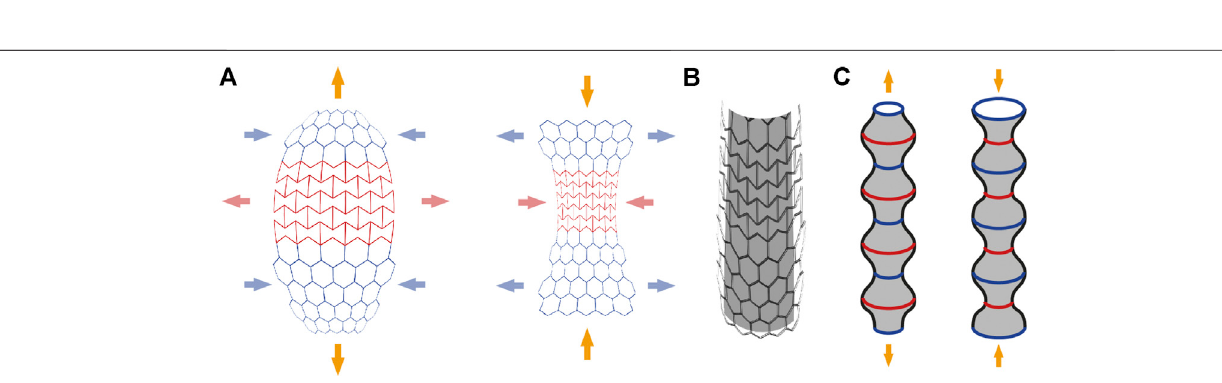
with the soil and other arti fi cial structures (row 1 and 22 of Table 1 ).